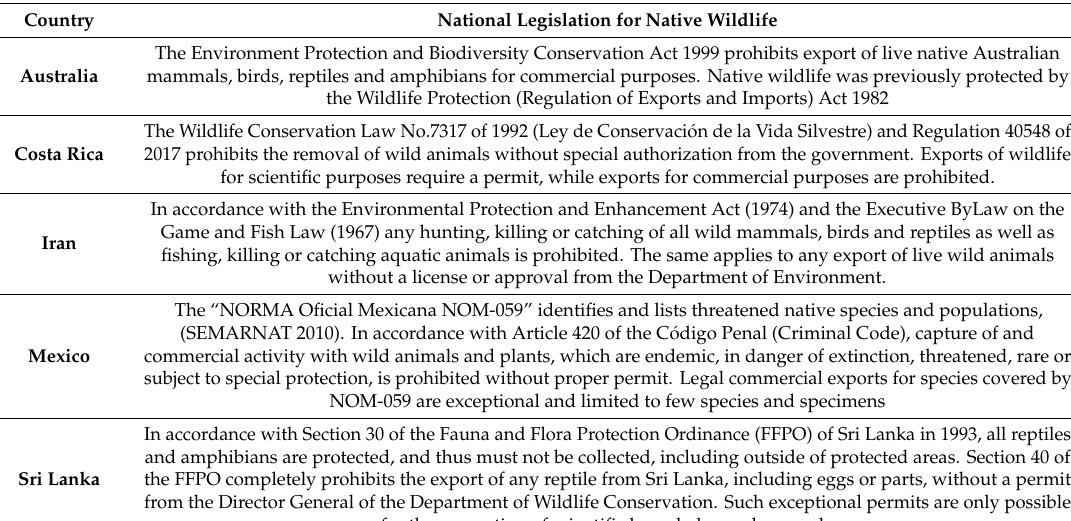
Table 2. National legislation in di ff erent range